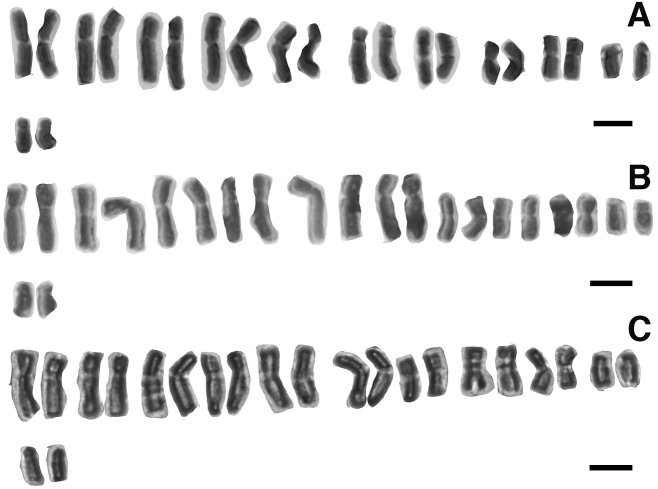
Chromosome of Polygonatum of Taiwan. AP.arisanensevar.arisanenseBP.arisanensevar.chingshuishanianumCP.arisanensevar.formosanum. Scale bar: 5 μm.